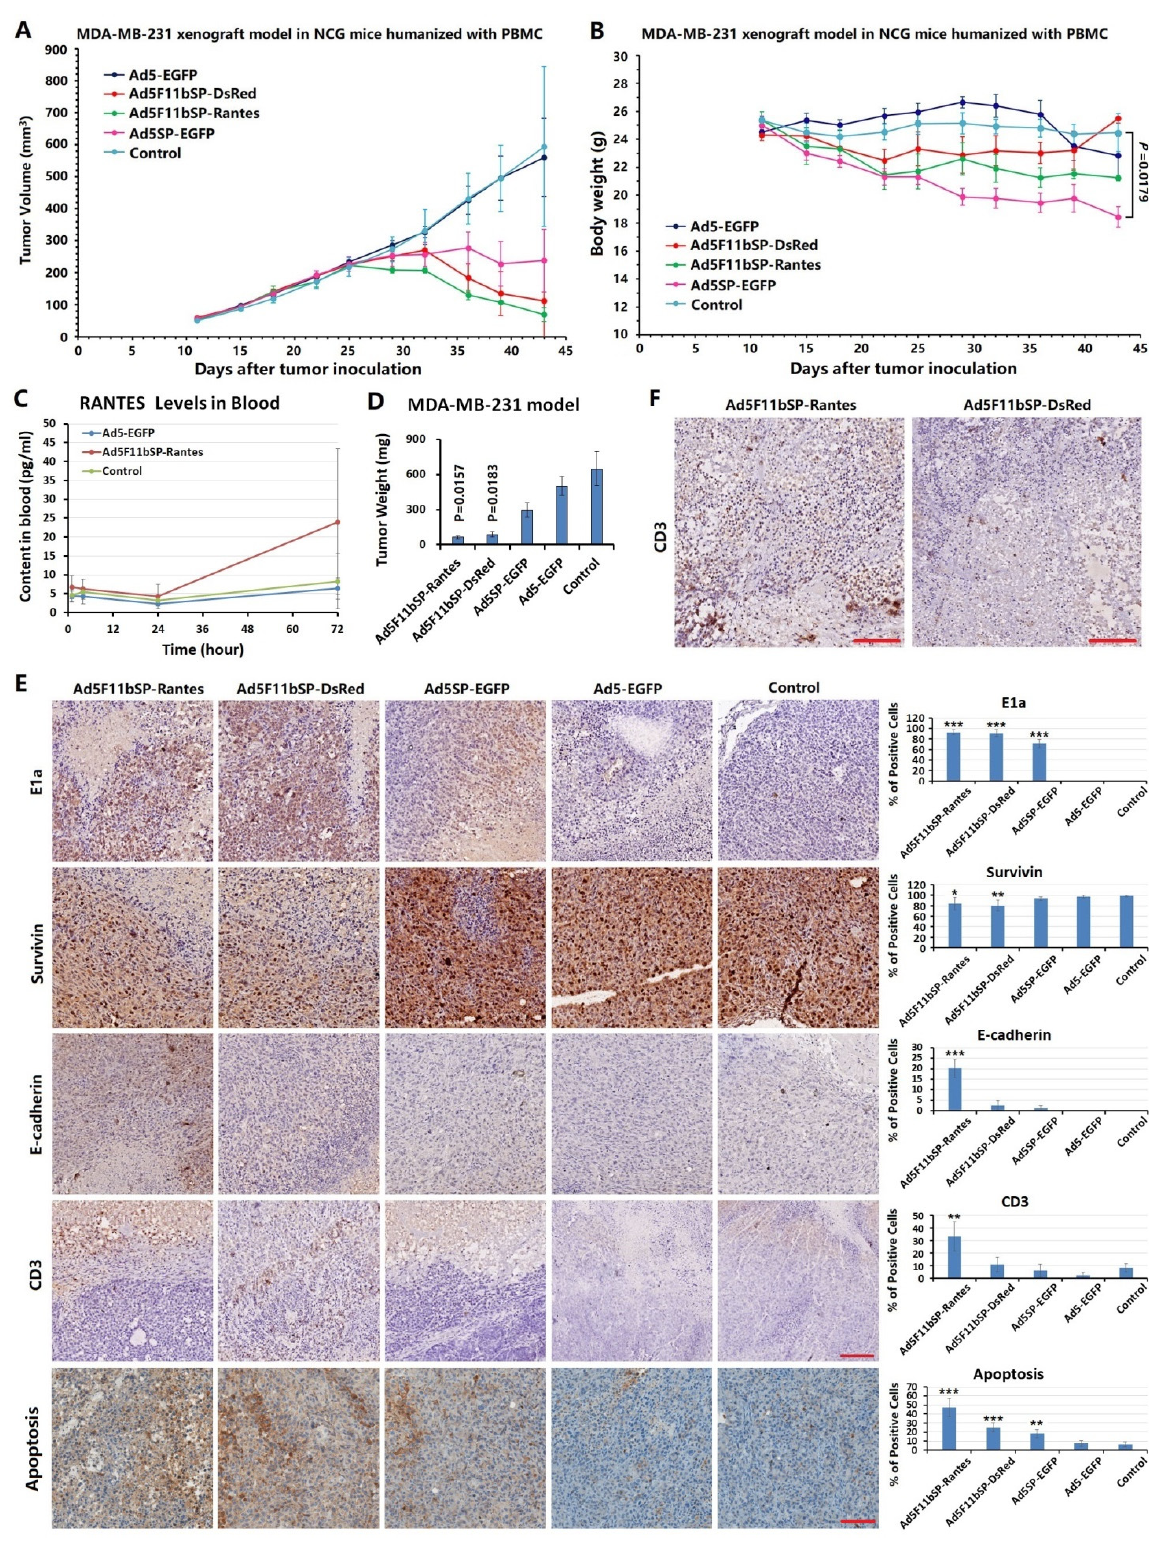
Figure 4. Anti-tumor experiment of TNBC xenograft model treated by oncolytic adenovirus Ad5F11bSP-Rantes. ( A ) MDA-MB-231 xenograft tumor model in NCG mice was established by inoculation of tumor cells at 1 × 10 7 cells per mouse; the immune system of mice was humanized by injection of human PBMCs on the second day after tumor cell inoculation. After tumor formation, the animals were randomly divided into 5 groups (Ad5F11bSP-Rantes, Ad5F11bSP-DsRed,